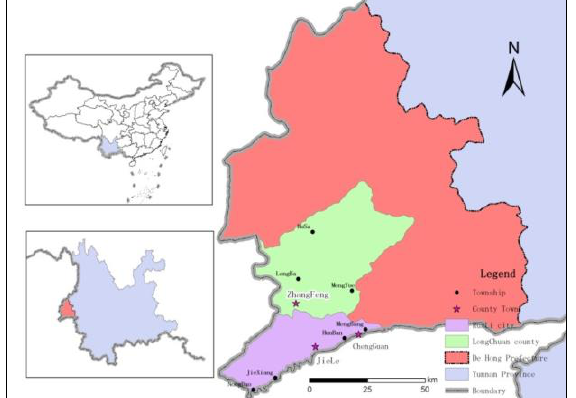
Figure 1. The location of Dehong Dai and Jingpo Autonomous